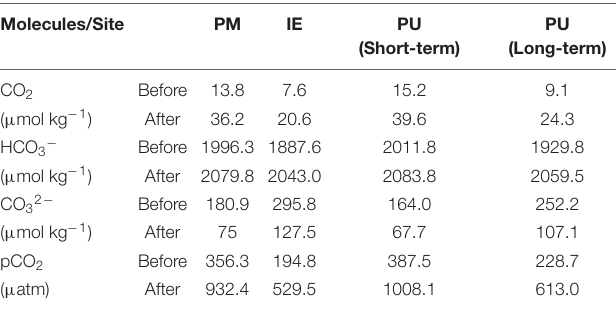
TABLE 2 | Estimated concentrations of CO 2 , HCO 3 − , CO 32 − before and after the pH-reducing treatment.